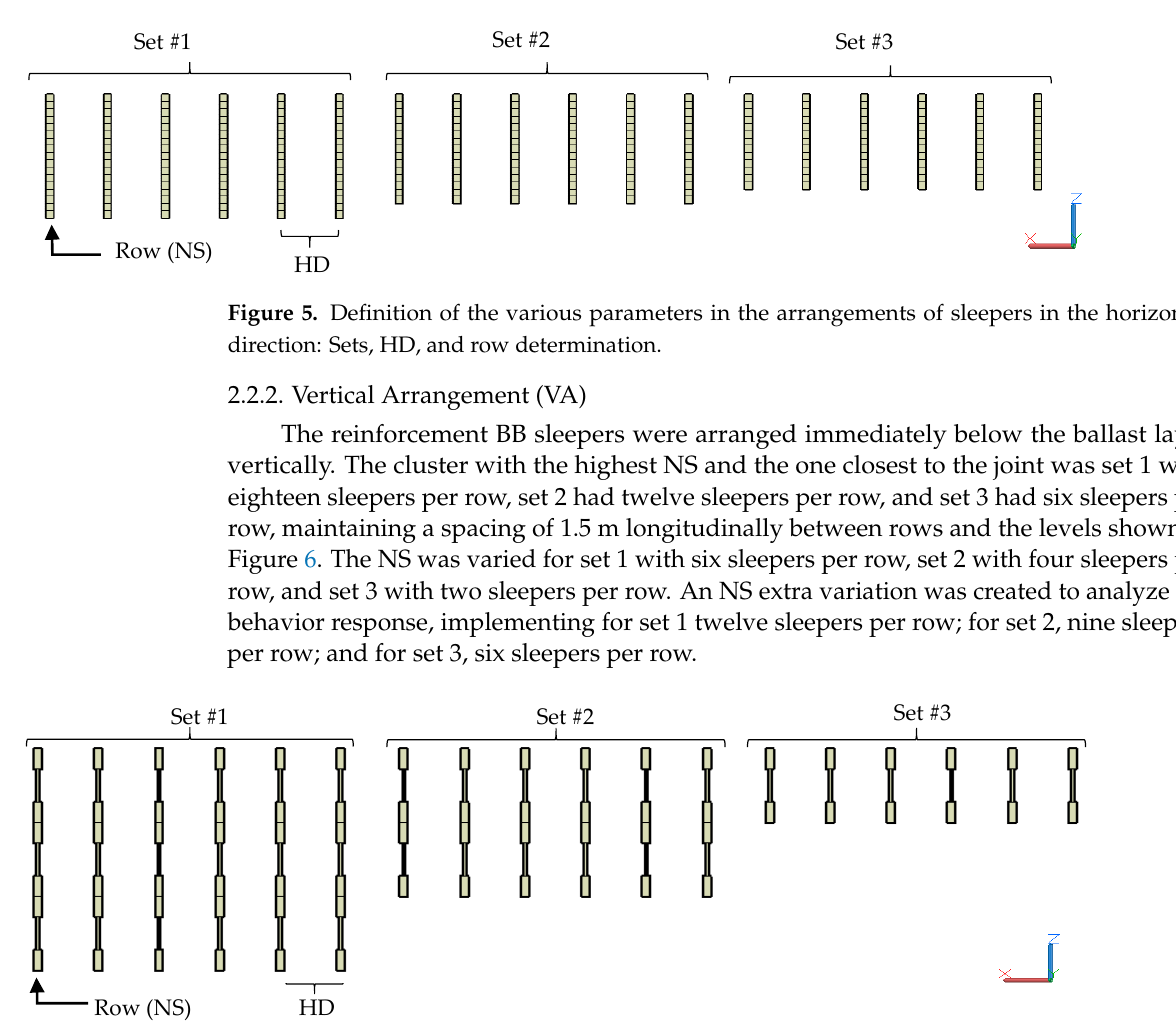
Figure 4. Horizontal BB sleeper reinforcement arrangement example.